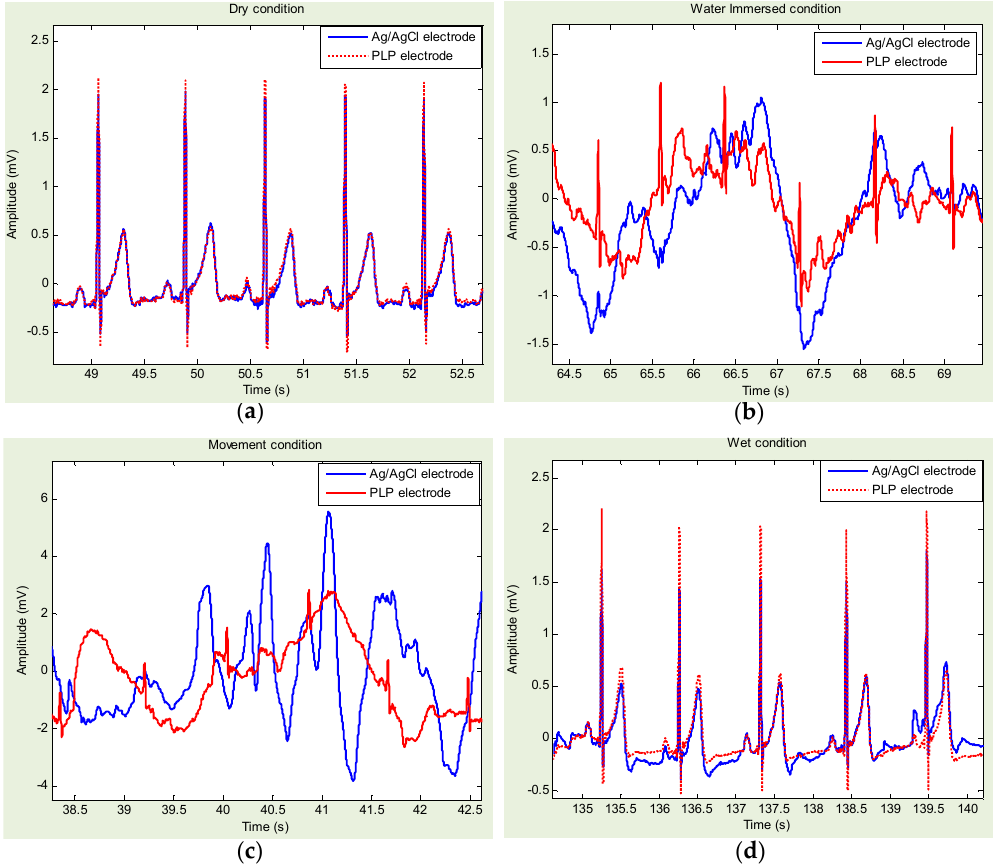
Figure 7. (Experiment II—Pencil lead powder-type (PLP) electrode compared with Ag/AgCl electrode) Example of electrocardiogram (ECG) signals for each experimental condition: ( a ) dry condition; freshwater immersed condition: ( b ) without movement; and ( c ) with movement; and ( d ) freshwater wet condition. ECG signals acquired with Ag/AgCl (blue line) and PLP electrodes (red line).